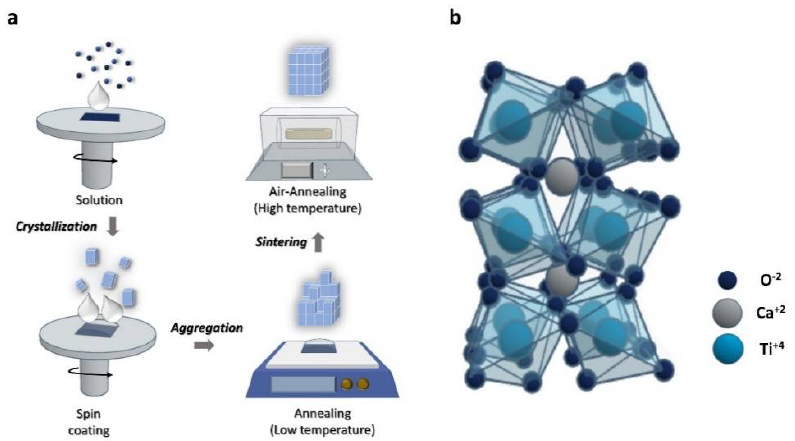
Figure 2. ( a ) Schematic diagram of CTO thin film preparation and ( b ) orthorhombic structure of CTO. Figure 5a–c,d–f show 2D and 3D AFM images of three different CTO layers.